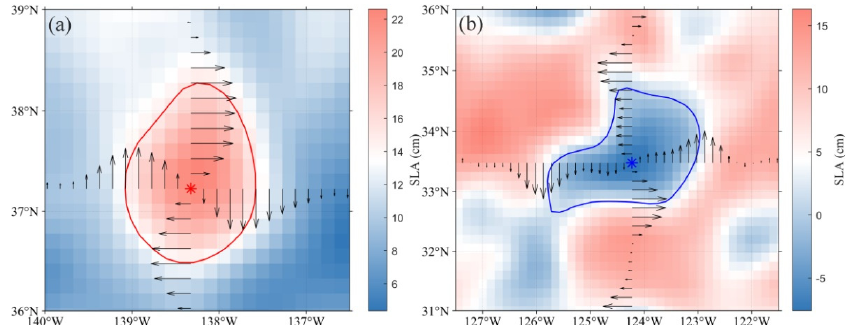
Figure 18. Eddies centers of ( a ) AE and ( b ) CE as estimated in the GOMEAD dataset in the KE region on 1 January 2019. Red and blue curves represent contours of selected AE and CE, respectively. The stars represent eddy centers. Arrows indicate flow direction.